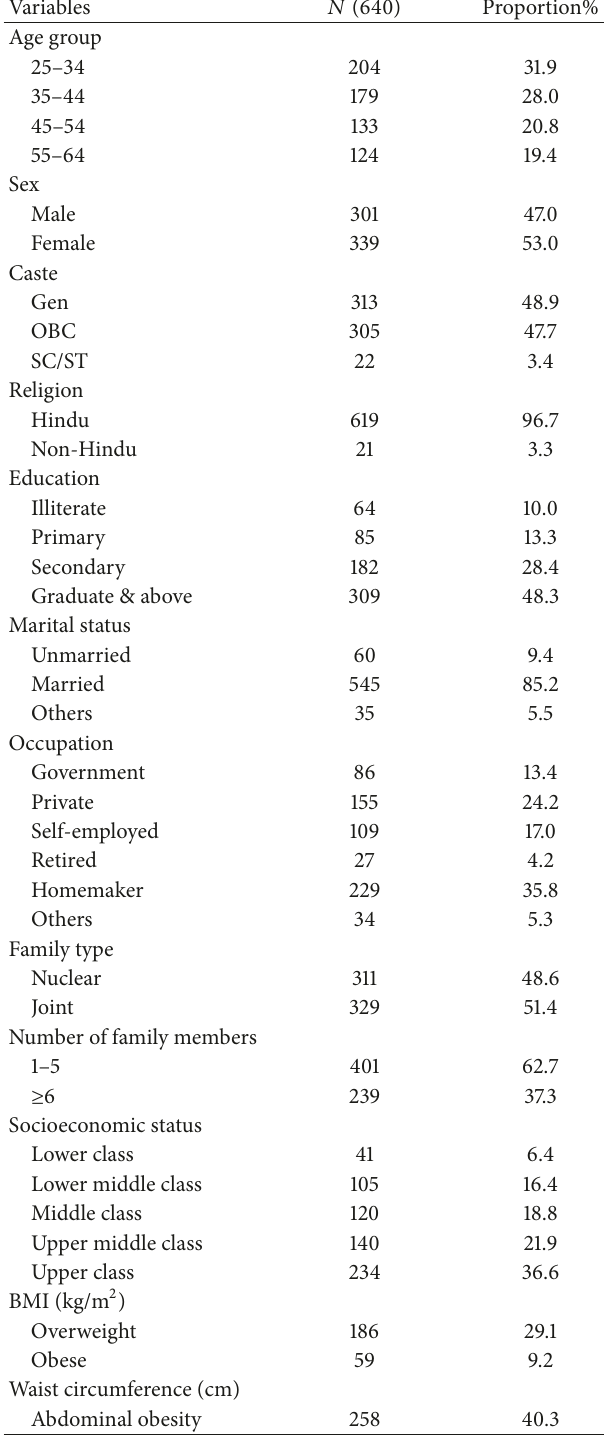
Table 2: Background characteristics of the study subjects ( 𝑁